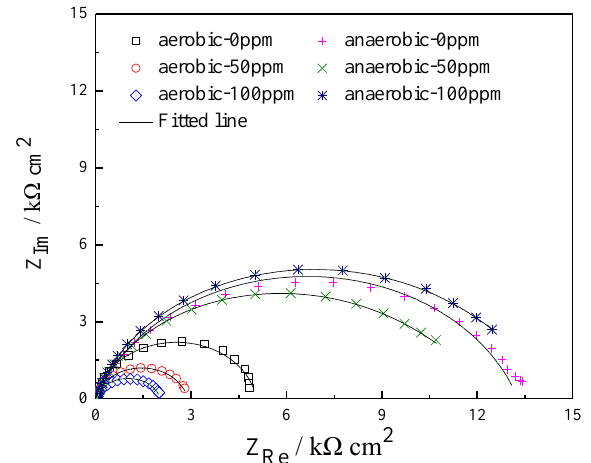
Figure 4. Nyquist diagrams of X80 pipeline steel under aerobic and anaerobic conditions.